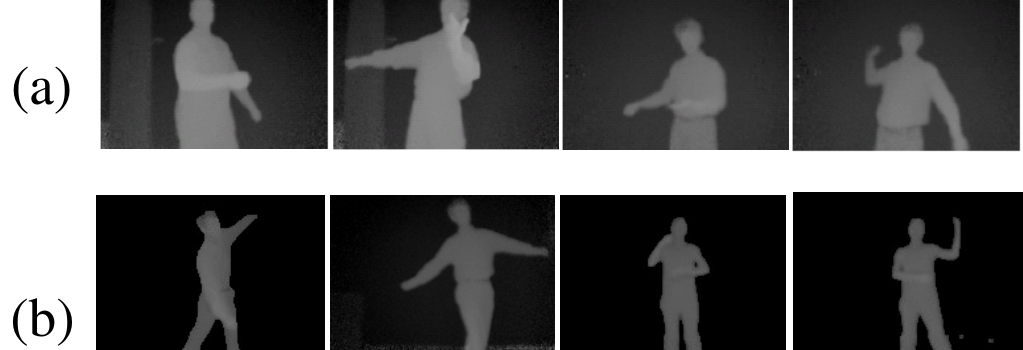
Figure 1. Depth data (a) Example upper body postures; (b) Example whole body